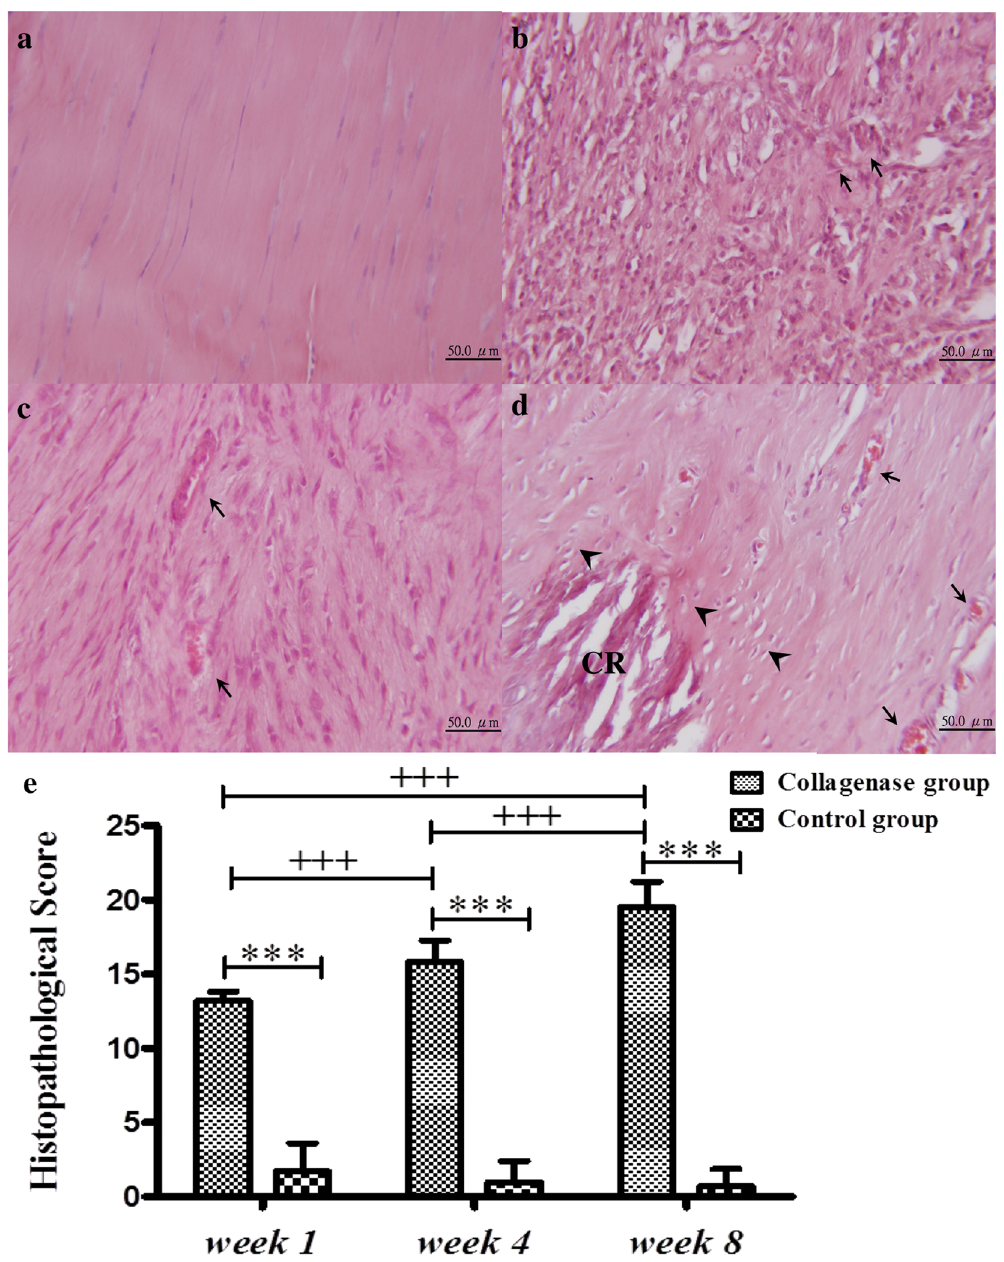
Figure 1. Hematoxylin and eosin staining and histopathological scores of Achilles tendons after an intratendinous injection of collagenase or only needle punctures. Control ( a ) and injured tendons at weeks 1 ( b ), 4 ( c ), and 8 ( d ). The summary of histopathological score ( e ). CR, calcified deposits; arrowhead, chondrocyte- like cells; arrow, vascular structure. The histopathological scores: * compared with the Control group; + compared within the Collagenase group; * / + p < 0.05; ** / ++ p < 0.01; *** / +++ p <